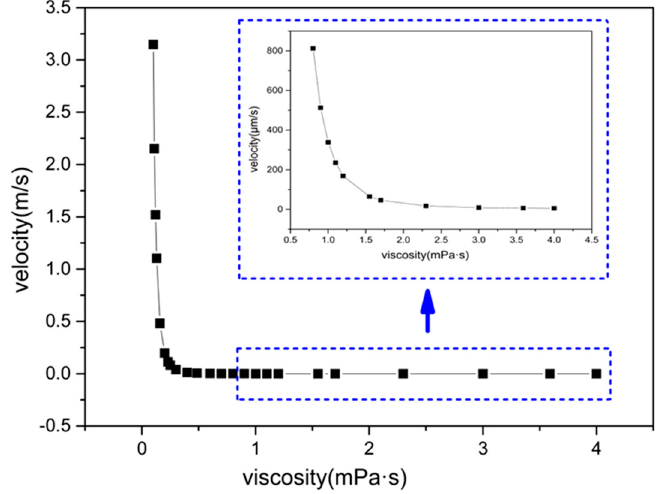
Figure 9. The velocity versus viscosity of fluid.